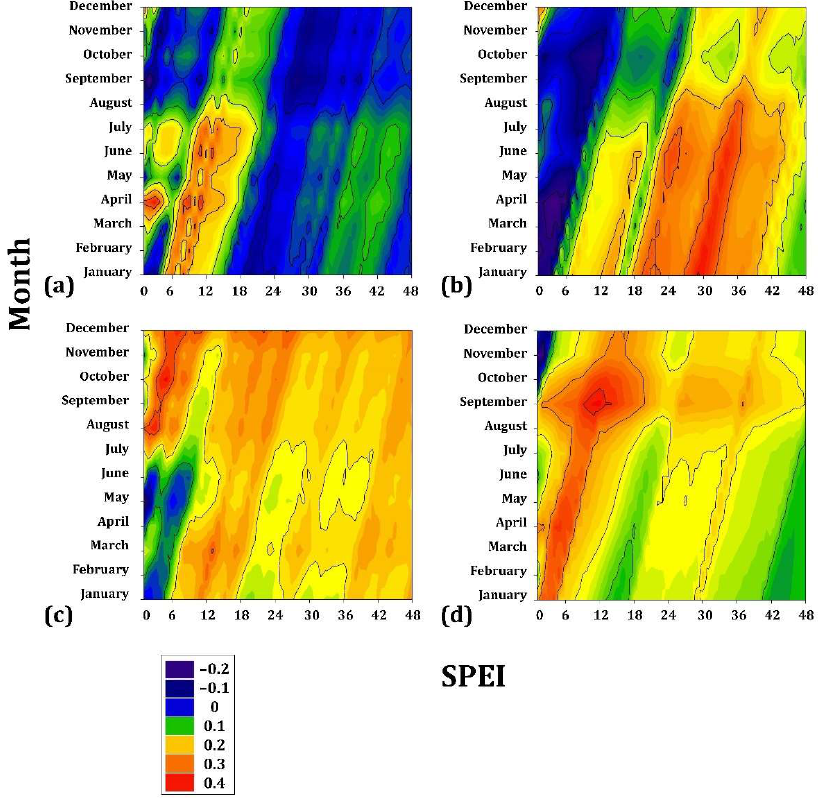
Figure 4. Drought–growth associations calculated for four Mexican conifer species (at <1900 m asl) by relating the SPEI drought index to the residual growth-ring width chronologies. The SPEI was calculated in scales of 1 to 48 months ( x axes) from JAN to DEC in the current year of growth ( y axes). ( a ) Pinus caribaea var. hondurensis ; ( b ) P. oocarpa; ( c ) P. jeffreyi ; ( d ) P. cembroides. The Pearson correlation coefficients (r) are indicated using color